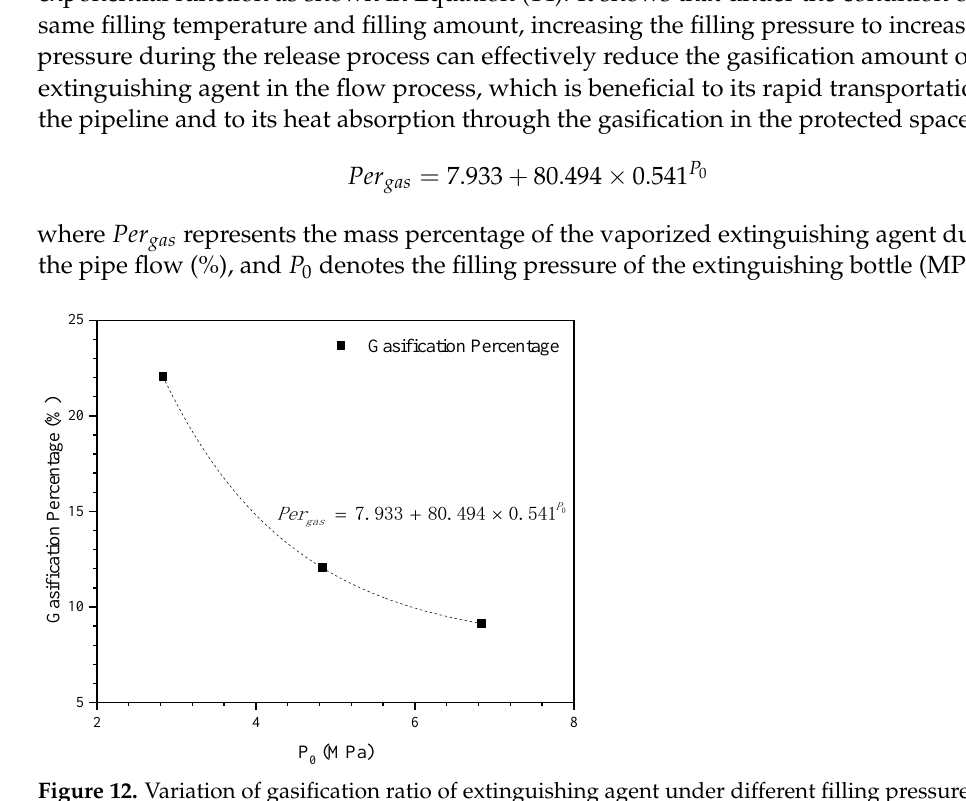
Figure 12. Variation of gasification ratio of extinguishing agent under different filling pressures .